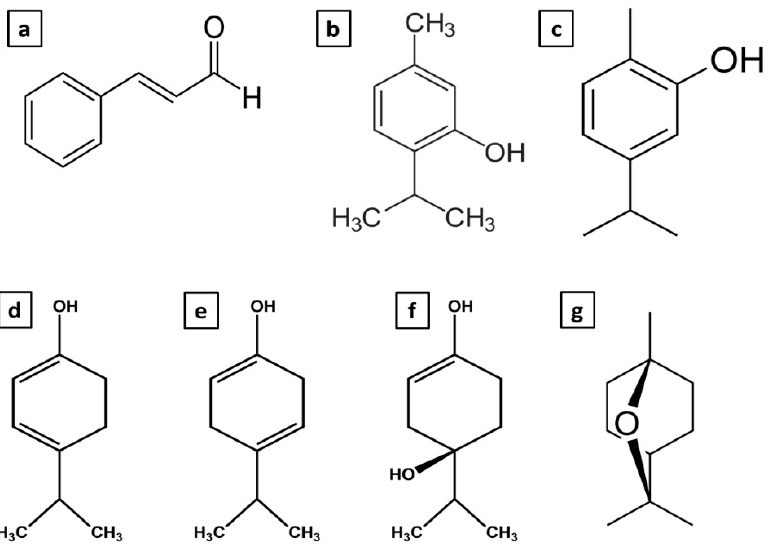
Figure 3. ( a ) Cinnamaldehyde, ( b ) and ( c ) two main oregano oil ingredients thymol and carvacrol, ( d ), ( e ) and ( f ) three main tea tree oil compounds α -terpinene, γ -terpinene, and terpinen-4-ol, and ( g ) 1,8-cineole one of the main ingredient of eucalyptus oil.